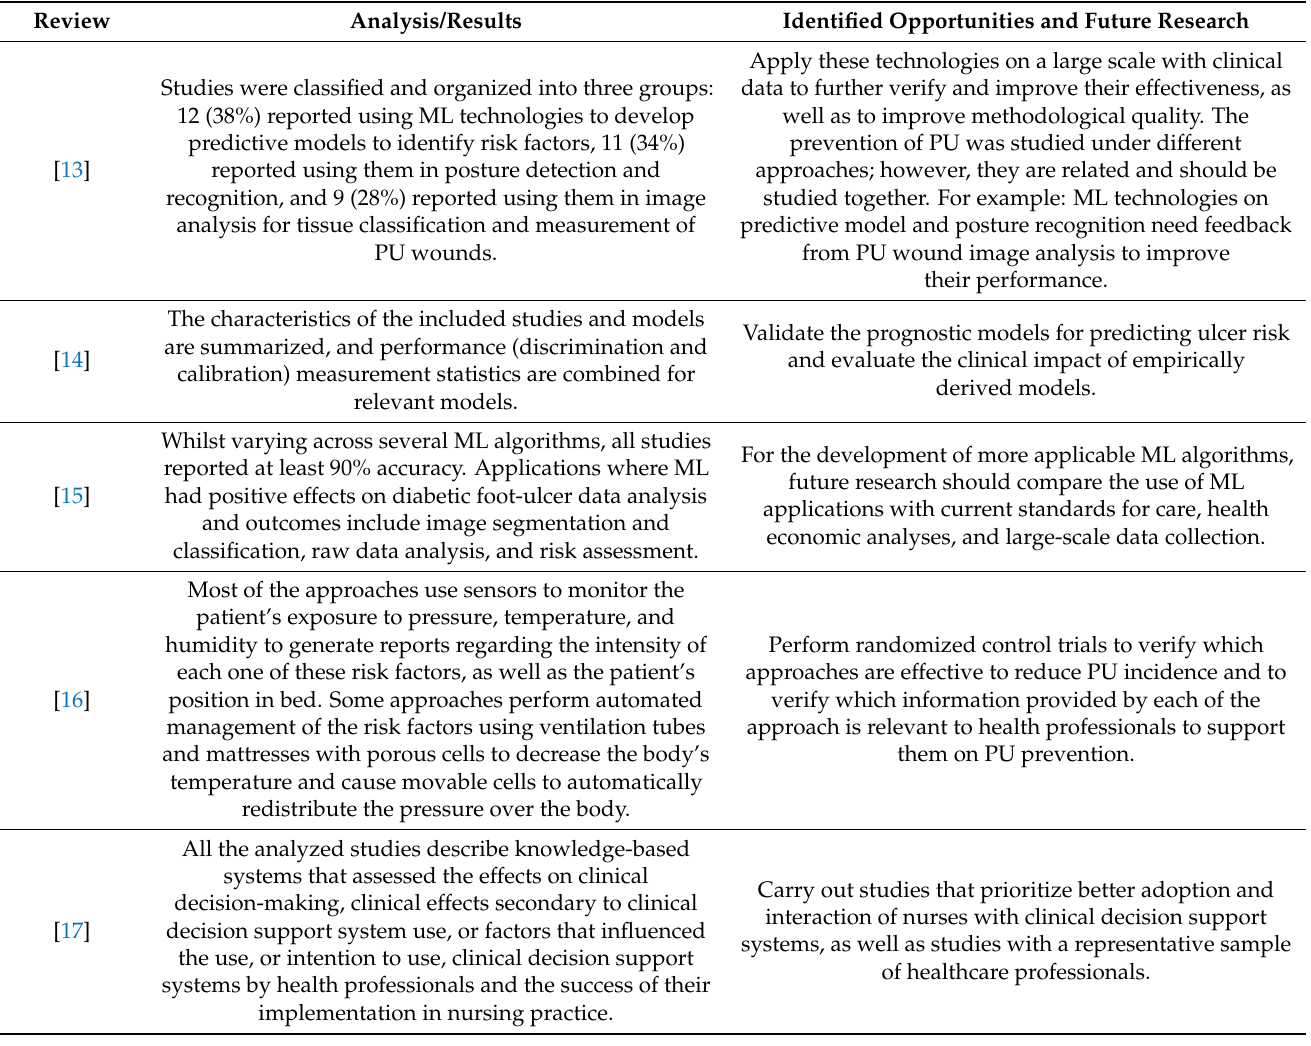
Table 2. Studies reviewing ML algorithms for PU prevention: results, opportunities, and future research.